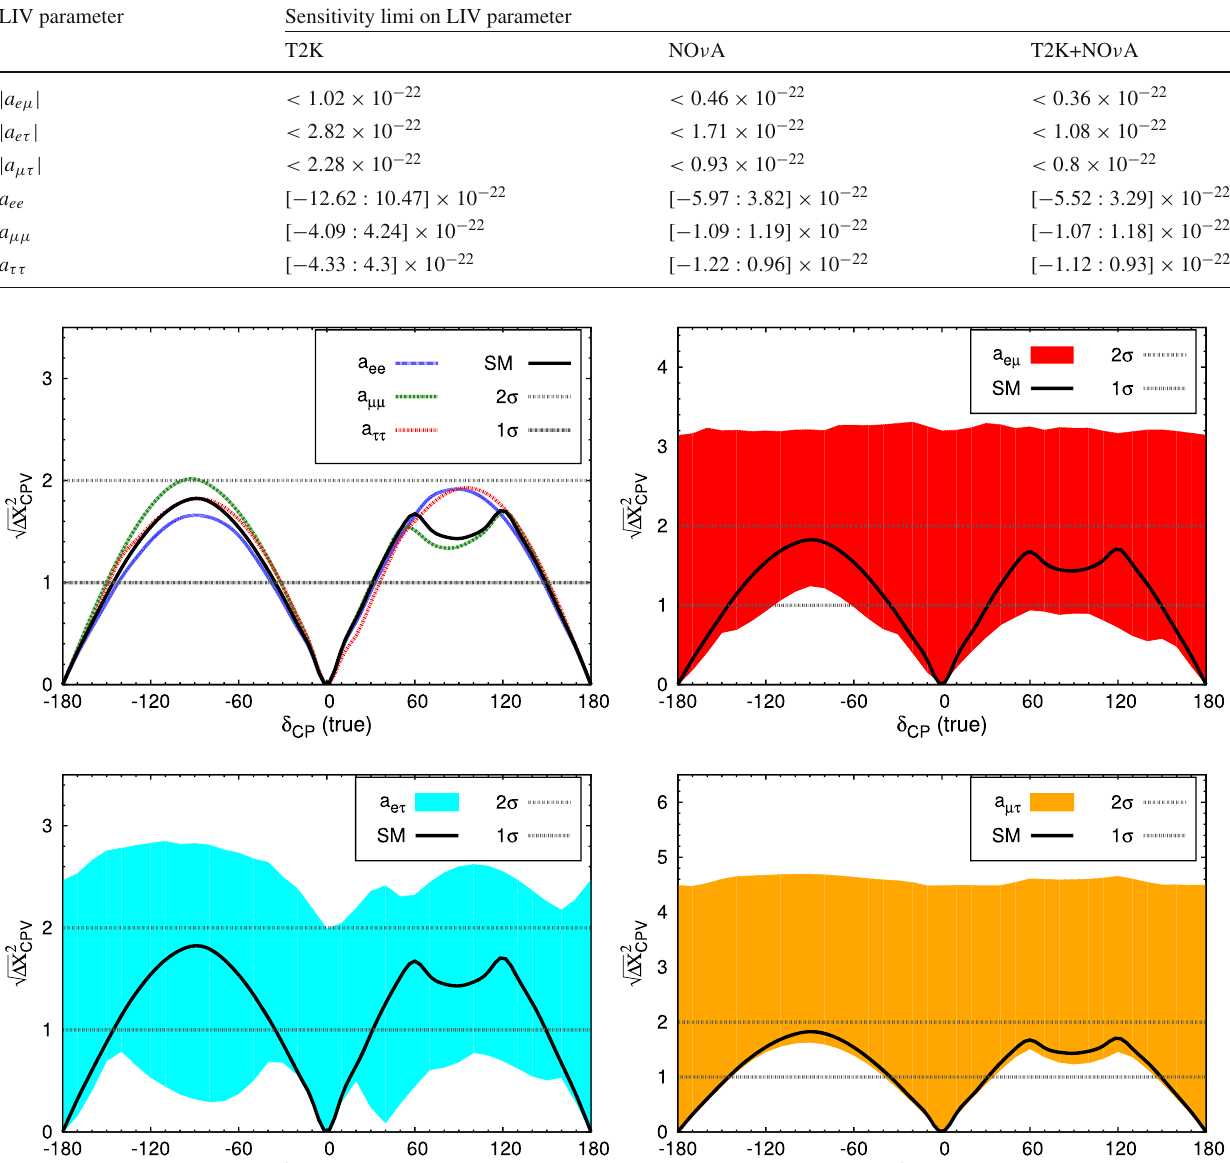
and non-diagonal LIV parameters in e μ , e τ and μτ sectors shown in top-right, bottom-left and bottom-right panels